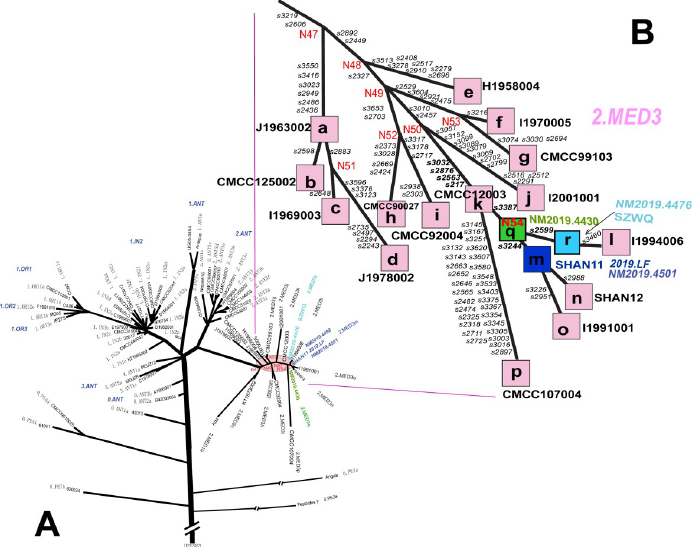
Fig 1. Phylogenetic tree of Y . pestis and the lineage relationships in 2.MED3 population. A: Phylogenetic relationships rooted in Y . pseudotuberculosis (IP32953) were determined by the maximum likelihood method based on genomic SNPs, which included 40 Y . pestis strains in this study and 65 genomic sequences of Y . pestis from GenBank. Note: The length of the branch in Fig 1A does not reflect the SNP polymorphic frequency; B: The phylogenetic position and lineages of Y . pestis in 2.MED3 population in this